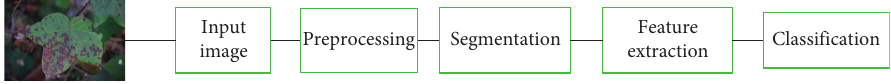
Figure 1: Leaf disease